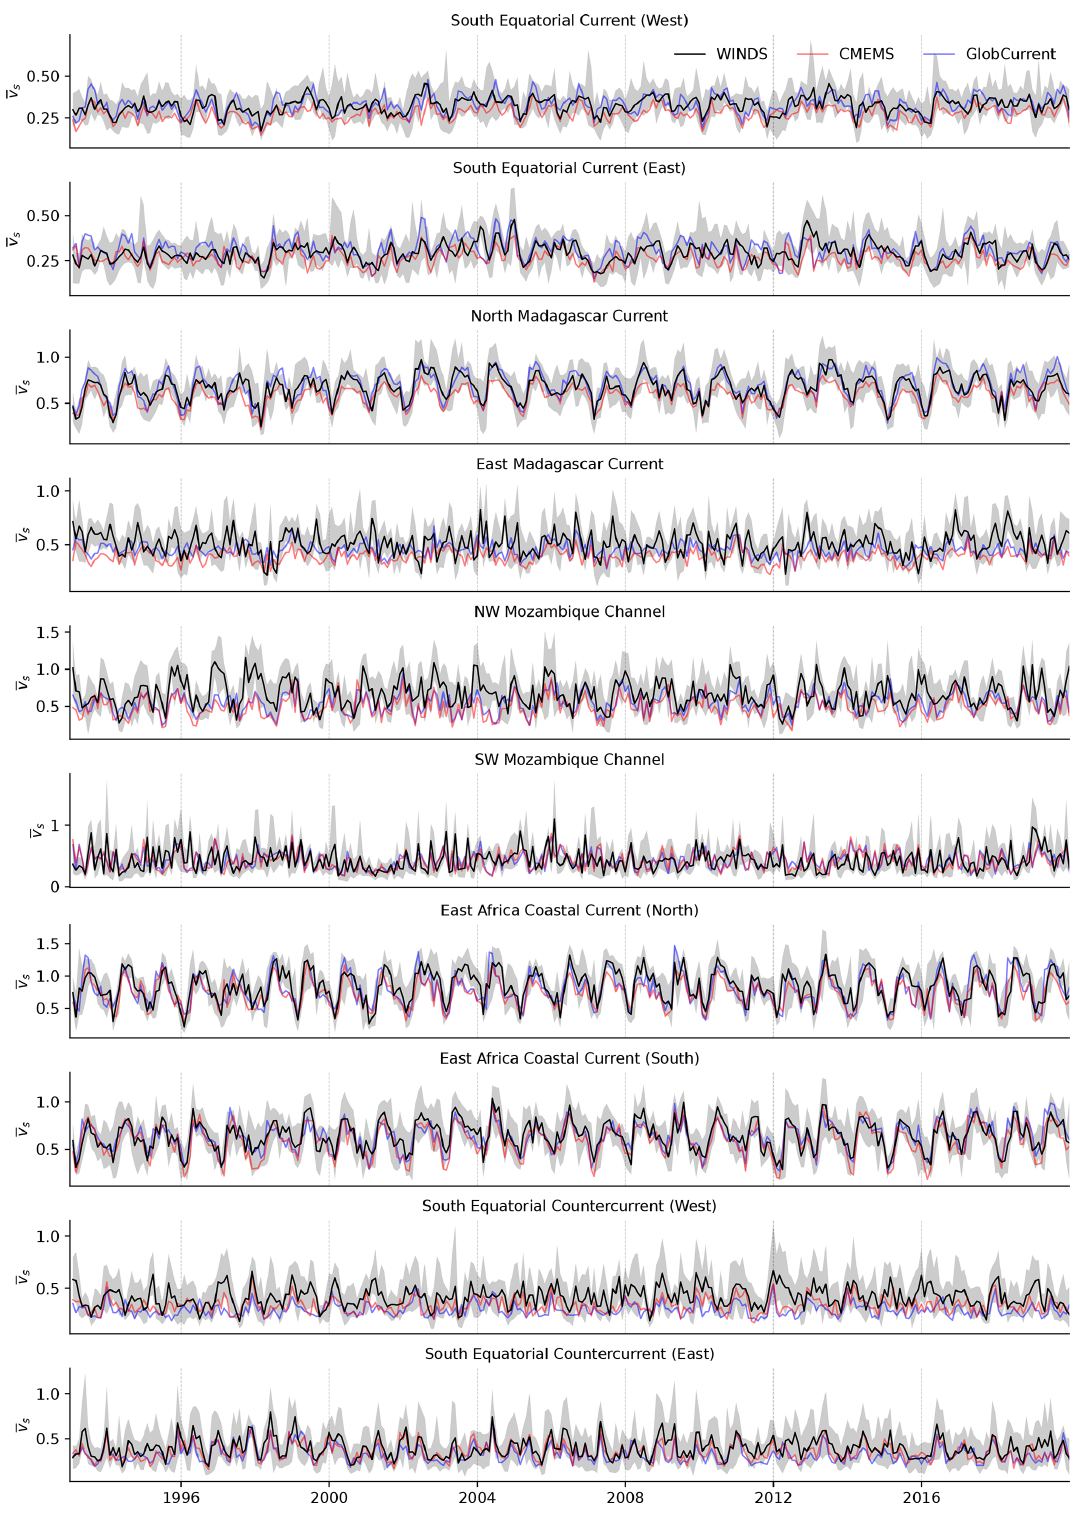
Figure 7. Monthly mean surface currents averaged across 10 key regions (see Fig. S8 for geographical reference) for WINDS (black, with grey shading representing the monthly range), CMEMS GLORYS12V1 (red), and GlobCurrent